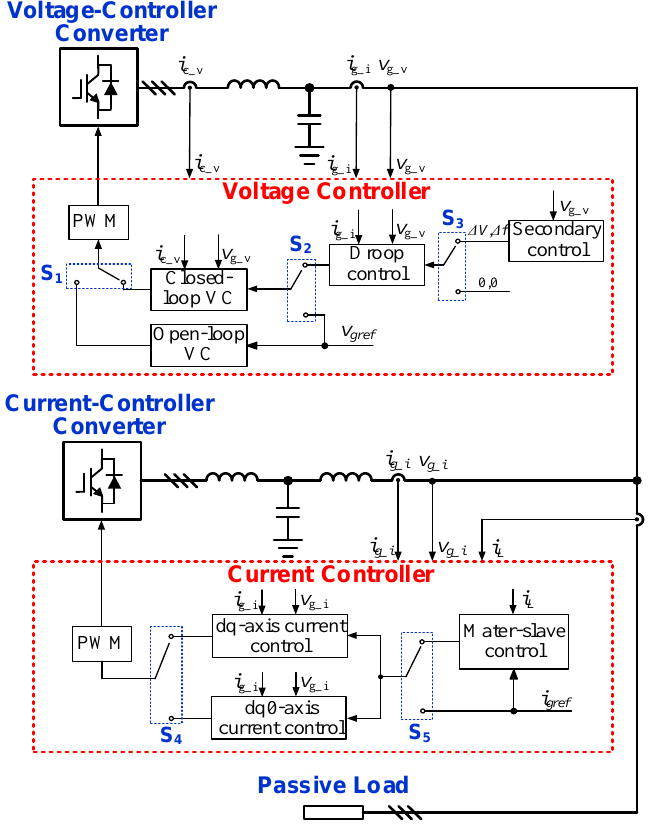
Figure 3. Control system of the proposed emulation approach. VCC: voltage-controlled converter, CCC: current-controlled converter, VC: voltage control.